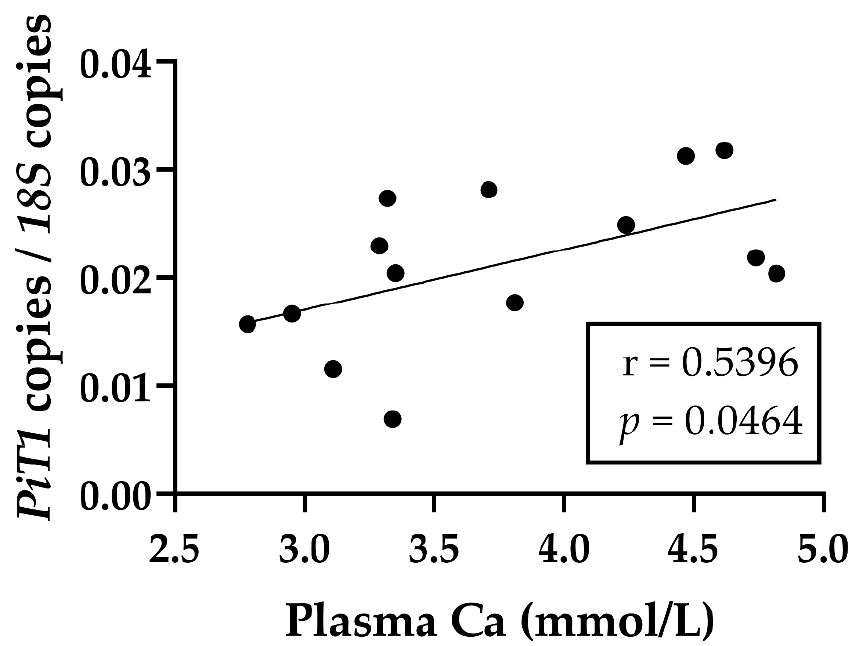
Figure 4. Linear regression of ileal PiT1 mRNA expression normalised to 18S with plasma Ca ( PiT1 mRNA = (0.0056 ± 0.0025), plasma Ca = (0.0003 ± 0.0096)) of goats fed different phosphorus supply.